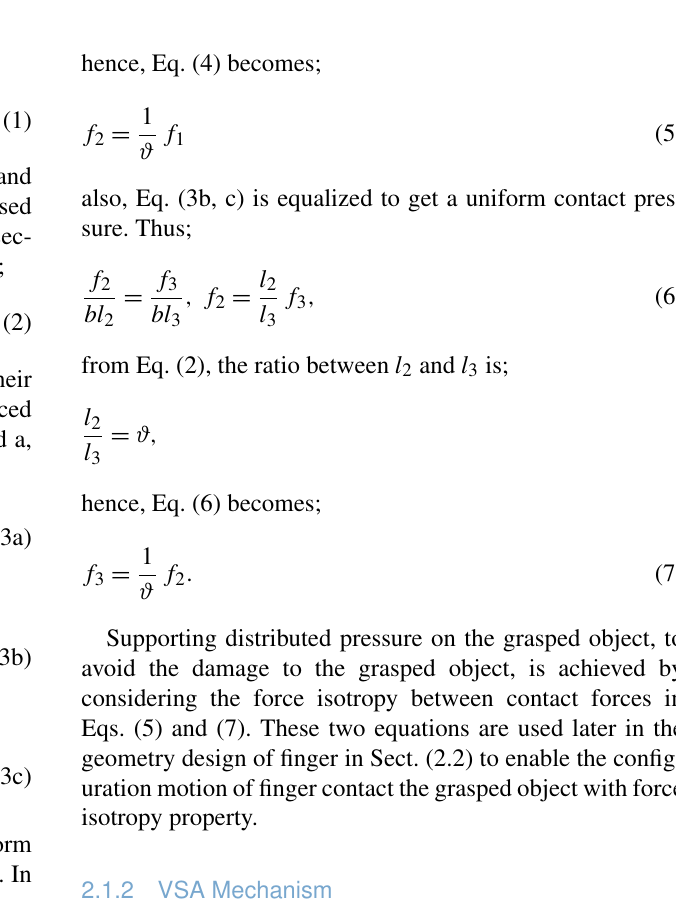
Figure 1. CPRF principle of operation (a) tendon actuating (b)